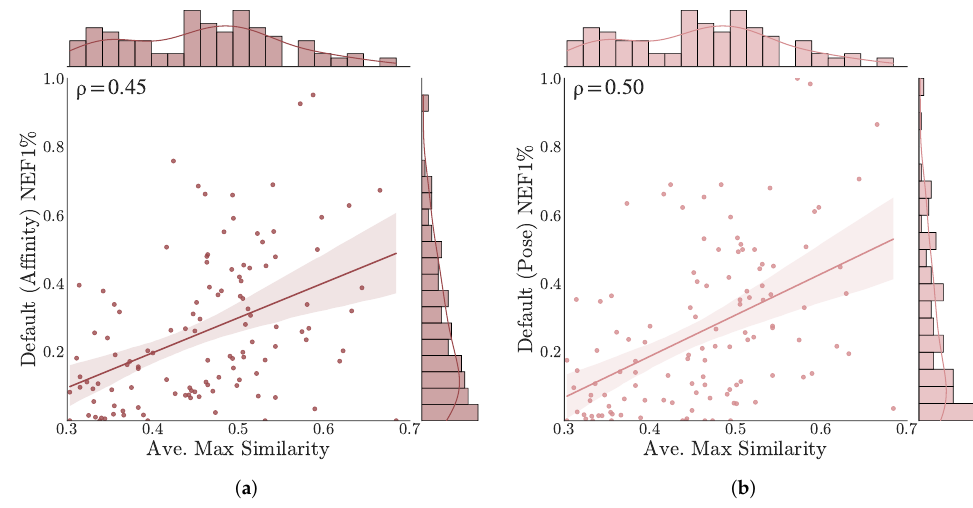
Figure 8. Correlation between similarity with training set and early enrichment performance for the Default ensemble ( a ) affinity and ( b ) pose scoring. For each benchmark, the average of the maximum similarity between active compounds and the PDBbind General set is computed using the Tanimoto coefficient of ECFP4 fingerprints.